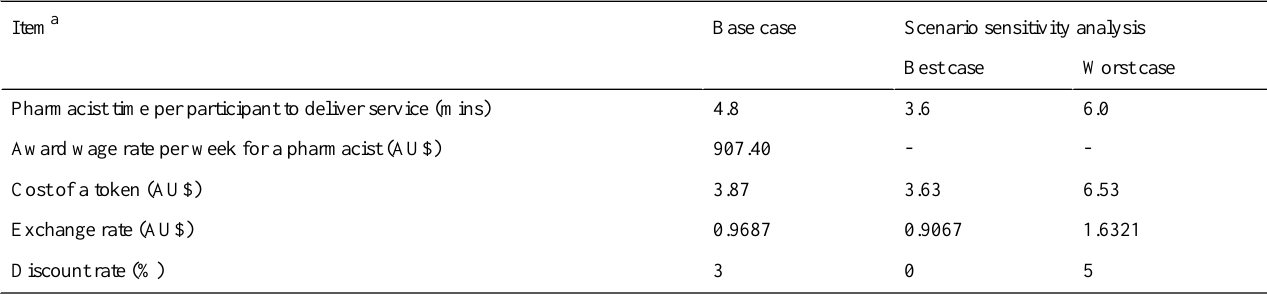
Table 1. Parameter values for base case and sensitivity